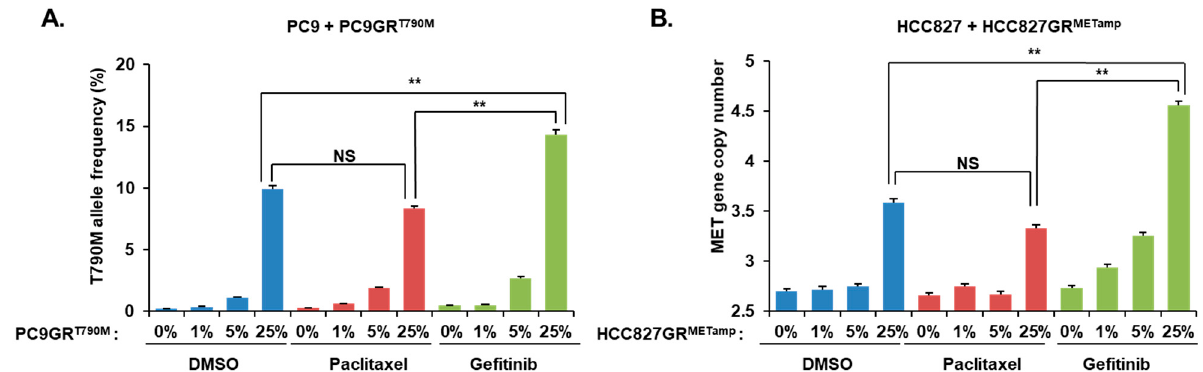
Figure 2. Selection of clones harboring resistant gene alteration in short term EGFR-TKI treatment. EGFR-TKI-resistant cells were spiked into parental EGFR-TKI-sensitive cells at the indicated percentages, and these cell mixtures were treated with DMSO, gefitinib (0.1 μ M), for 48 h. ( A ) PC9GR cells were mixed with PC9 cells at the indicated percentages. ddPCR assays were performed to evaluate the allele frequency of EGFR T790M mutations. ( B ) HCC827GR cells were mixed with HCC827 cells at the indicated percentages. ddPCR assays were performed to evaluate the C-MET gene copy number. In all graphs, the error bars represent the mean ± SEM. Statistical analysis was performed using t -test. ** p ≤ 0.05; NS, not significant.